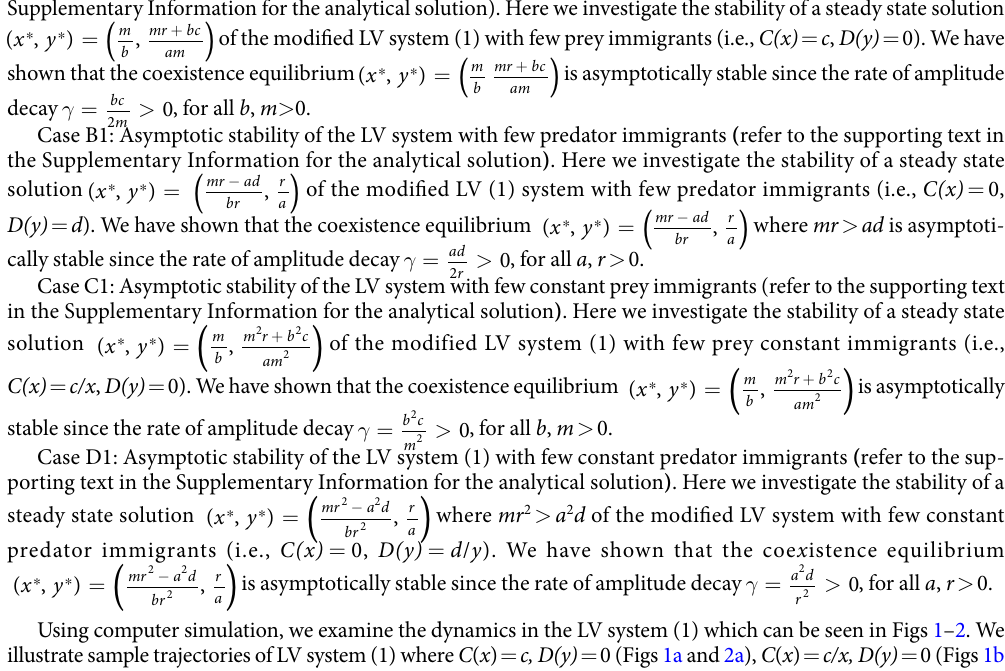
Case D1: Asymptotic stability of the LV system (1) with few constant predator immigrants ( refer to the sup- porting text in the Supplementary Information for the analytical solution ) . Here we investigate the stability of a steady state solution ⁎ ⁎